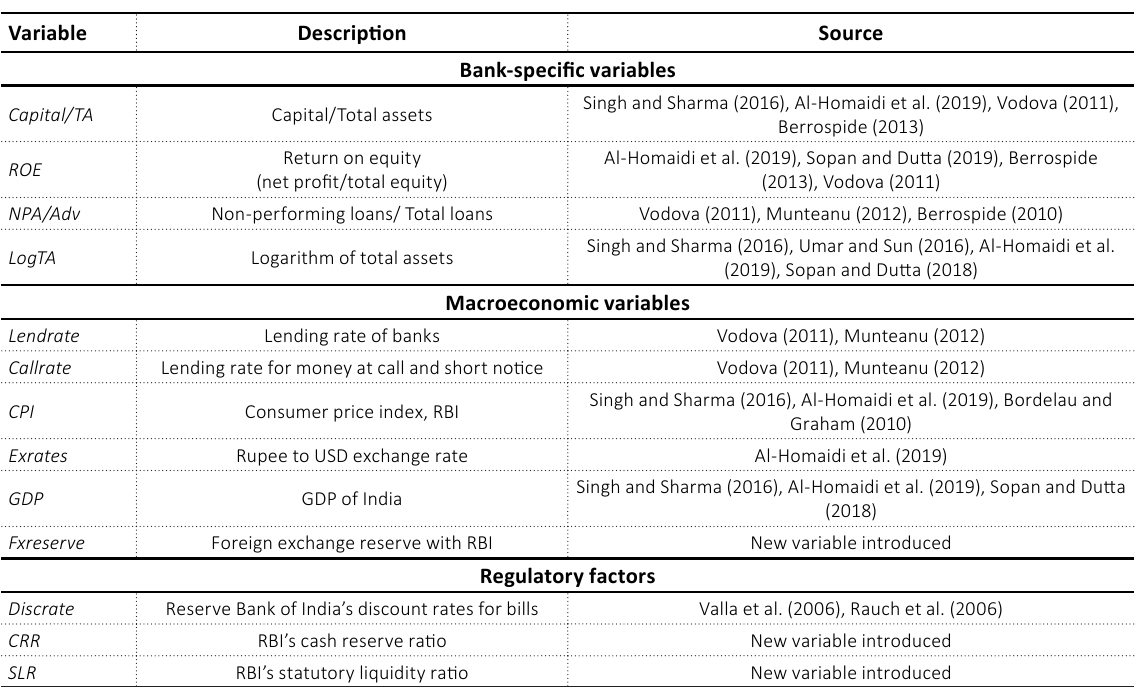
Table 1. Classification and description of independent